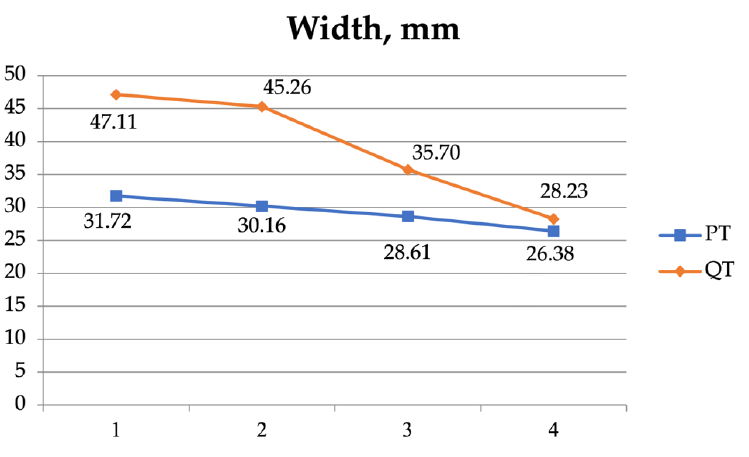
Figure 5. The cross-sectional area (CSA) of the patellar tendon (PT) and the quadriceps tendon (QT) at the 4 measurement sites.